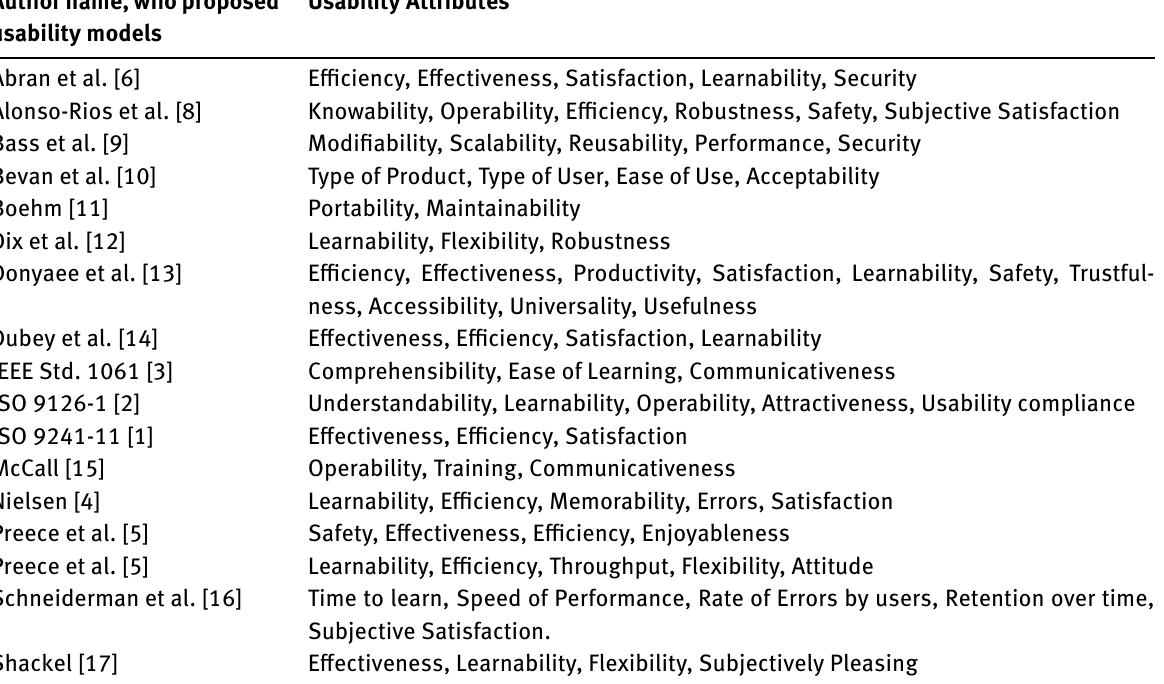
Table 1: Usability attributes in various proposed usability models Author name, who